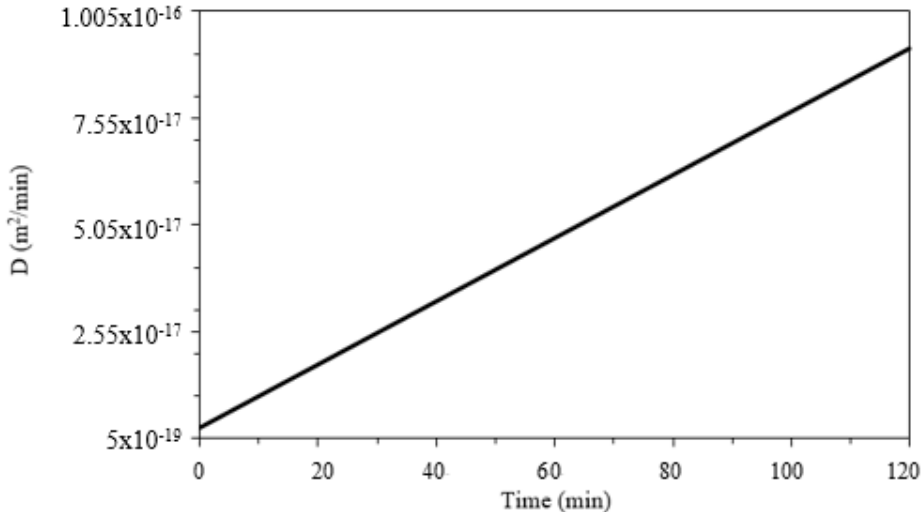
Figure 3. Diffusion coefficient (D) calculated trend (T = 25 °C, impeller rotational velocity = 20 rpm, Figure 3. Di ff usion coe ffi cient (D) calculated trend (T = 25 ◦ C, impeller rotational velocity = 20 rpm, time = 120 min, σ < 4%). time = 120 min, σ < 4%).